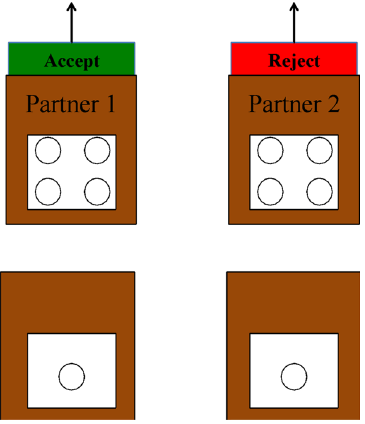
Figure 2. In the partner choice phase, participants learned about prospective partners’ decisions in an Inequity Game. Decisions were represented by laminated coloured cards (green for accept and red for reject ), which read either “accept” or “reject”, and resource allocations were represented by laminated pictures of Skittles. Coloured cards were stored in small brown paper bags on which were written the initials of children who had previously played the inequity game, represented here by “Partner 1” and “Partner